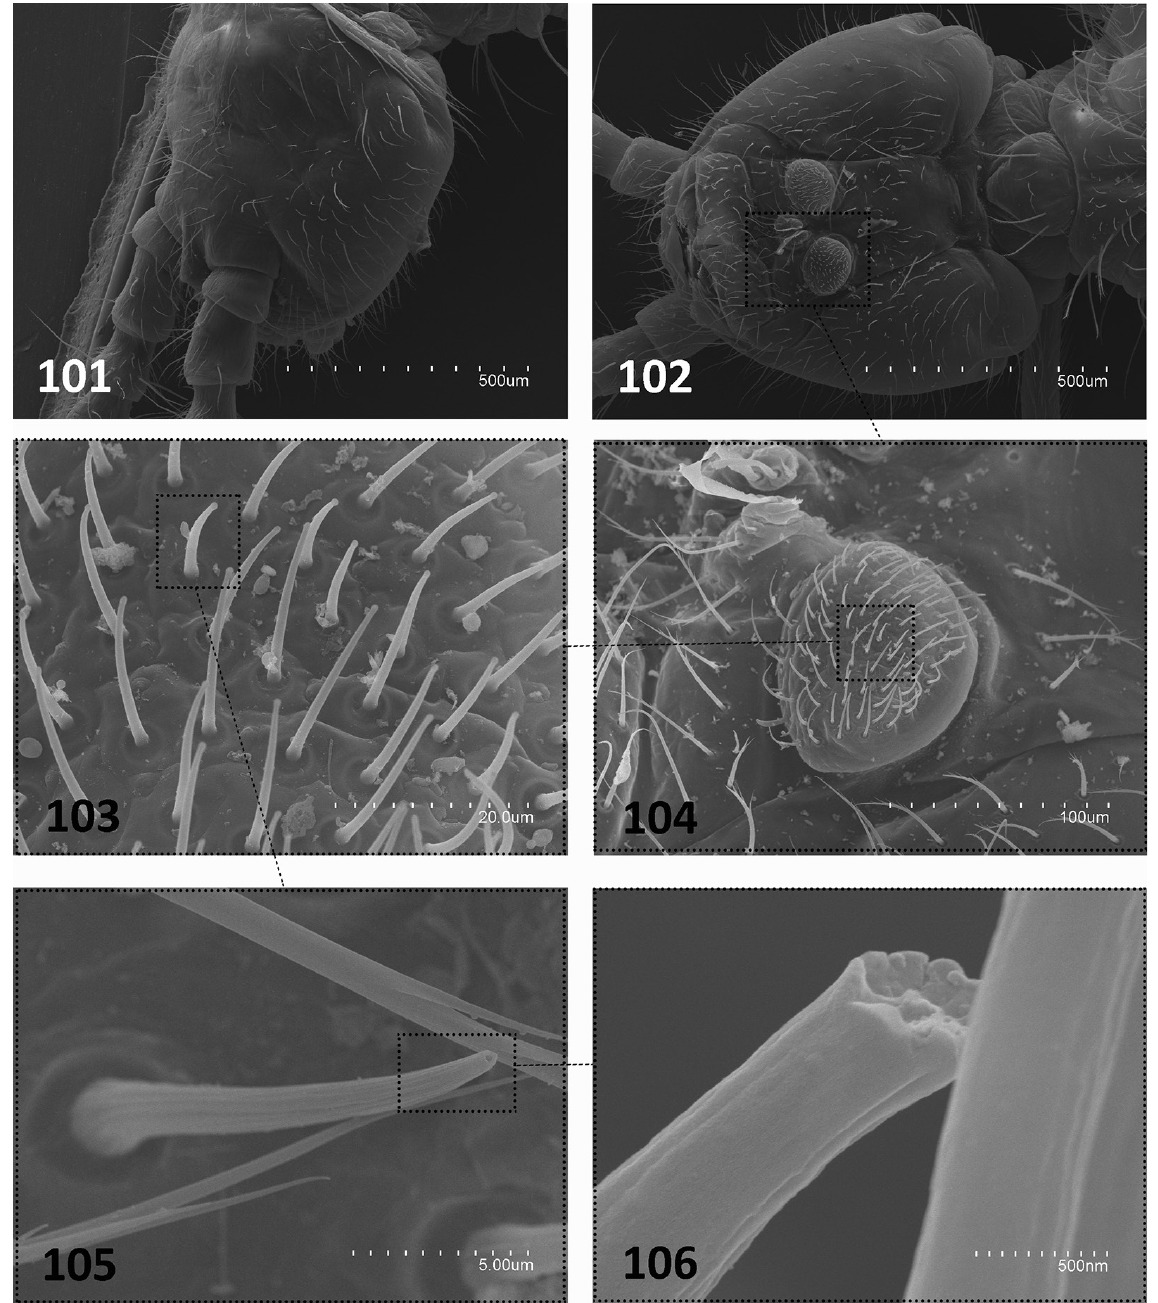
Figs 101–106. Plusiocampa ( Plusiocampa ) lagari Sendra & Condé, 1987, from Chorros Cave, Riopar, Albacete, Spain (Coll. AS). 101 . Head, dorso-lateral view. 102 . Head, ventral view. 103 . Detail of labial palp. 104 . Labial palp. 105 . Neuroglandular seta. 106 . Tip of neuroglandular